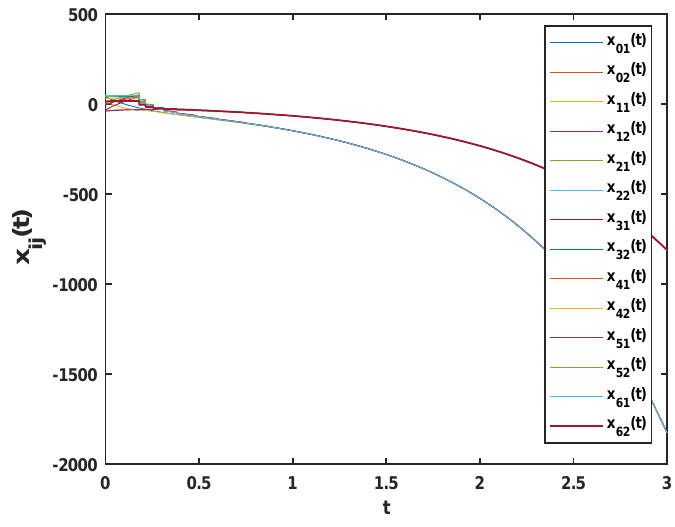
Figure 3. x ij ( t ) , i = 1,2, . . . ,6, j = 1,2 under ETM (7). The state curve of error system could be viewed in conjunction with the changing trend of x i ( t ) , i = 1, 2, . . . , 6. In addition to depicting the change trend of x i ( t ) , i = 1, 2, . . . , 6, the state curve of the error system can also be observed in Figure 4.